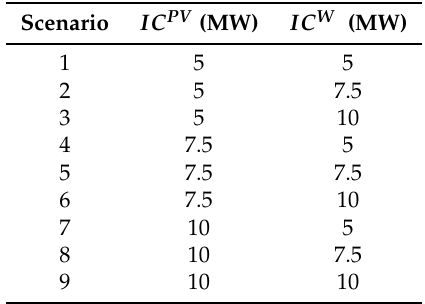
Table 2. Installed capacity of PV and Wind for each scenario.